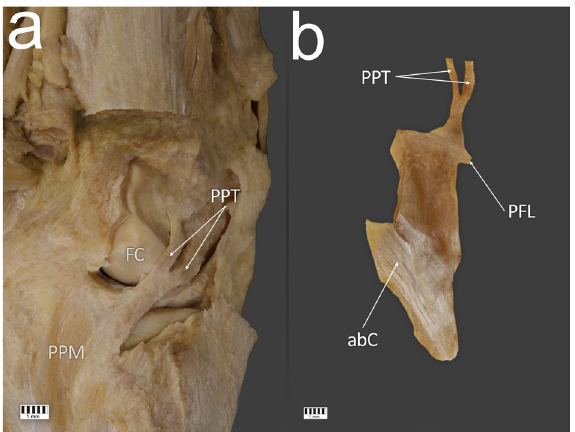
Figure 3. Type III of the popliteus tendon attachment. a Posterior view of the right knee joint with Type III of the popliteus tendon. b Isolated popliteus muscle with Type III of the popliteus tendon. FC—femoral condyle, PPT—popliteus tendon, PPM—popliteus muscle, PFL—popliteofibular ligament, abC—accessory band to the knee joint capsule. The Fig. 3 was taken with Canon EOS 6D camera with Canon EF 100 mm f/2.8 L Macro Is USM, and the signatures were made in Corel DRAW 12 (https:// www. corel draw. com/ pl/ pages/ corel draw-